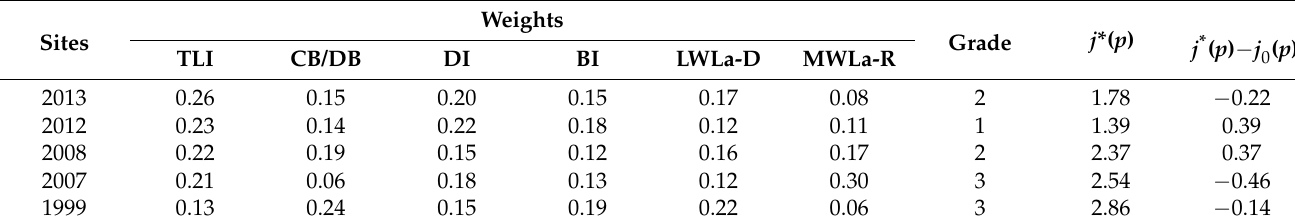
Table 4. Assessment results of the aquatic ecosystem in Poyang Lake in recent years. Weights Sites